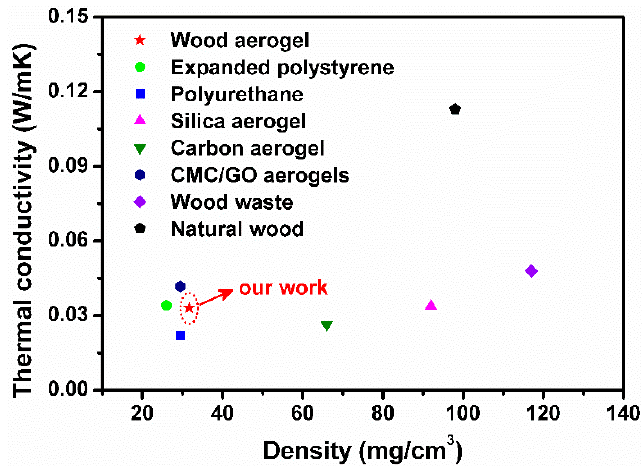
Figure 9. Comparison of the thermal conductivity and density of wood aerogel with reported thermal insulation materials.